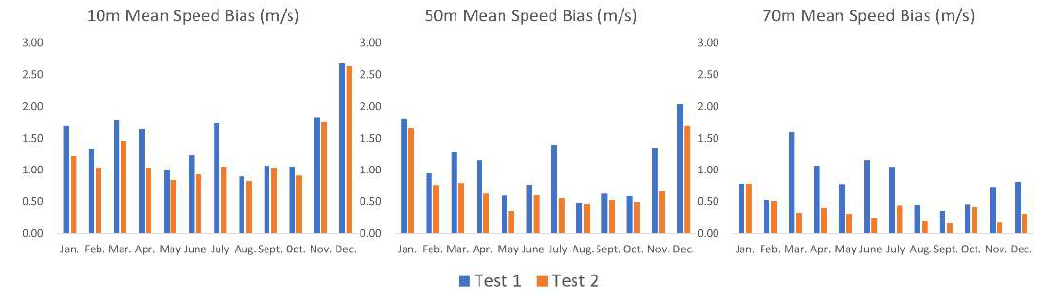
Figure 9. Average of the results of the mean speed bias from the seven towers.